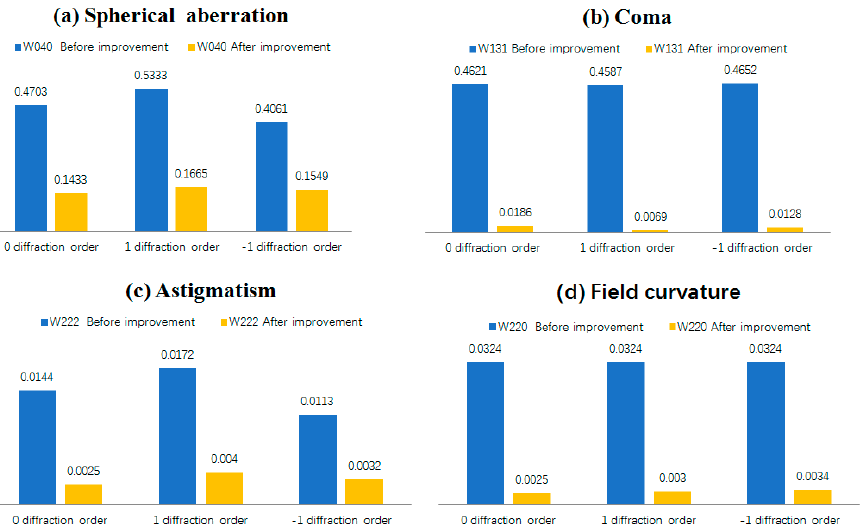
Figure 6. The comparison diagram of the Seidel coefficient of the tomographic microscopic system Blue corresponds to the Seidel coefficient for the unmodified chromatography system. The yellow color corresponds to the Seidel coefficient of the aberrated chromatography system. The adjacent blue and yellow rectangles correspond to one diffraction order of the chromatographic system.